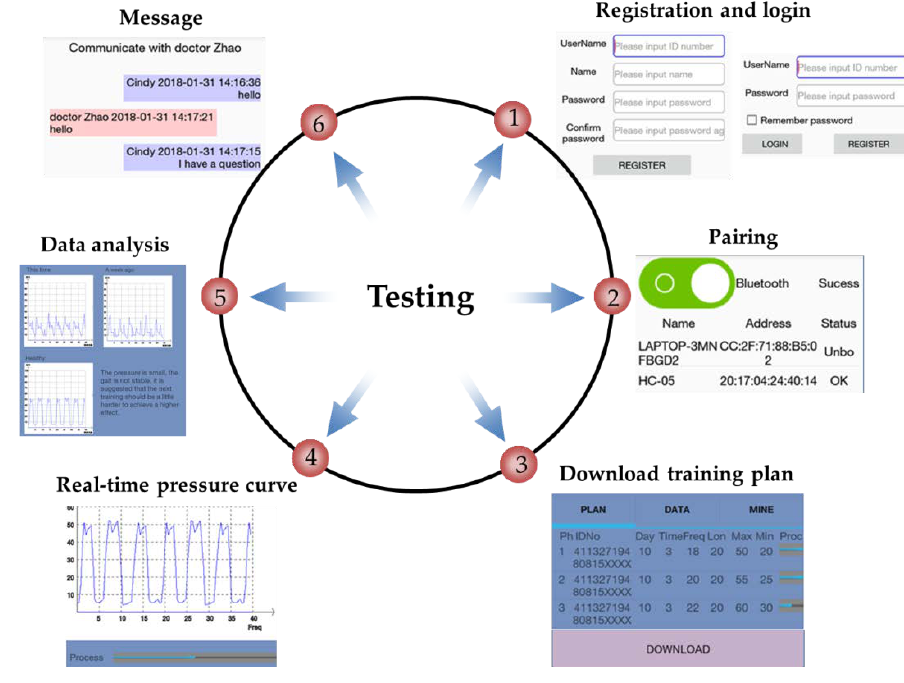
Figure 7. Illustrative images of testing process.